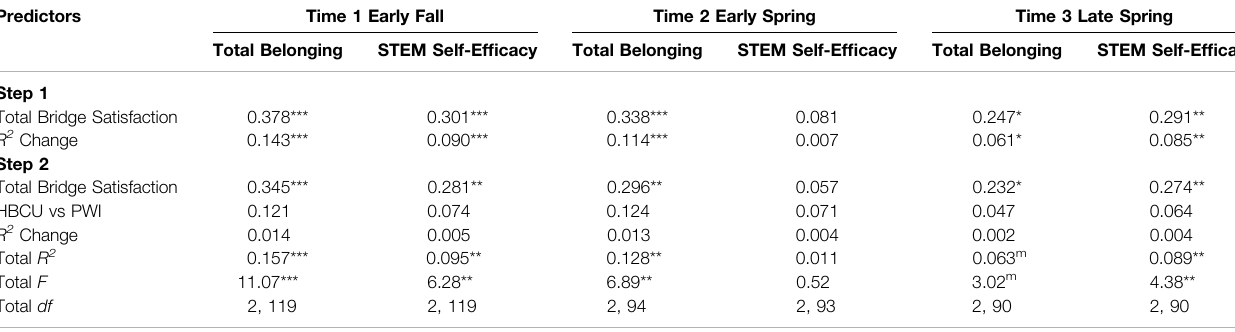
TABLE 3 | Regressions Predicting Total Belonging and STEM Self-Ef fi cacy from Total Bridge Satisfaction.